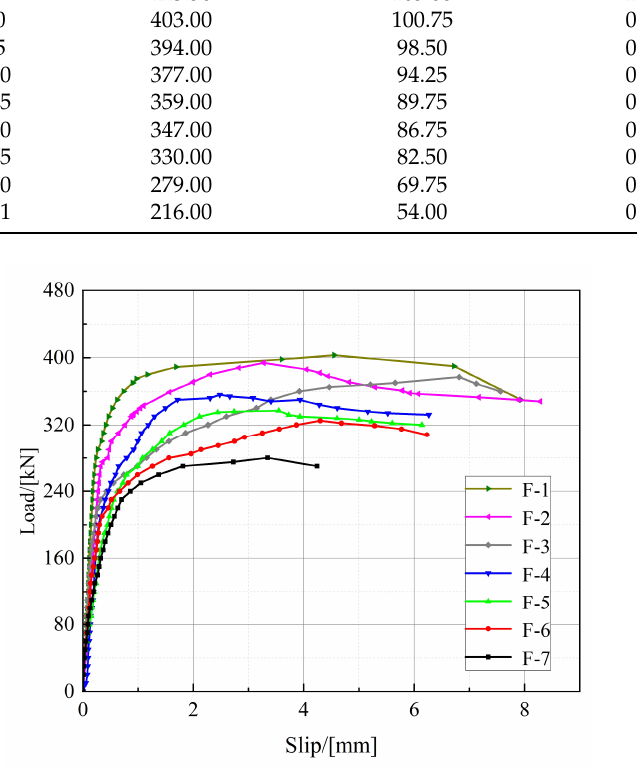
Figure 12. Load-slip curves of specimens under different cyclic loads.